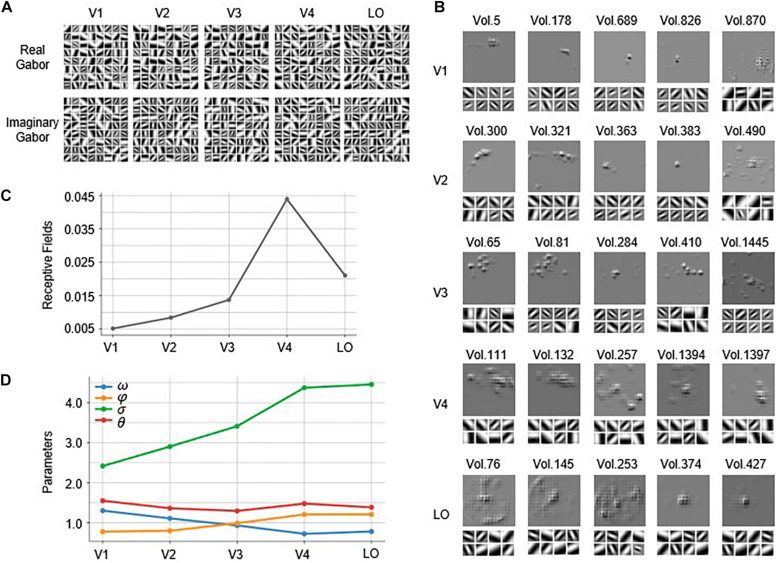
Voxel-to-voxel comparisons of GaborNet-VE, GWP, CNN-linear, and ETECR models. (A) Pairwise comparisons of GaborNet-VE model the GWP, CNN-linear, and ETECR models. Each of six performance plots shows a comparison of prediction accuracies for two models. Position along vertical axis indicates average prediction accuracy for models under comparison; shifts to right or left along the horizontal axis indicate a relative improvement in prediction accuracy for one of compared models. Color of each hexagonal bin indicates log-scaled number of voxels in a local region of plot. Histogram at top of each plot represents distribution of relative improvements for all voxels whose prediction accuracy is above 0.27 (p < 0.001, randomization test) for at least one of two models. This distribution corresponds graphically to all voxels above red dashed line. Number on each side represents fraction of voxel predictions that are improved under corresponding model. In all plots, a shift of the data toward right indicates an advantage for GaborNet-VE model, whereas a shift toward left indicates an advantage for reference models. Upper plots display data for voxels in primary visual cortex (V1, V2, and V3); lower plots display data for voxels in intermediate and higher visual areas (V4 and LO). (B) Joint comparisons of GaborNet-VE model and all of reference models. Each plot contains percentages of voxels in one ROI best predicted by each encoding model. Red, gray, green, and blue curves represent GaborNet-VE, GWP, CNN-linear, and ETECR models, respectively.